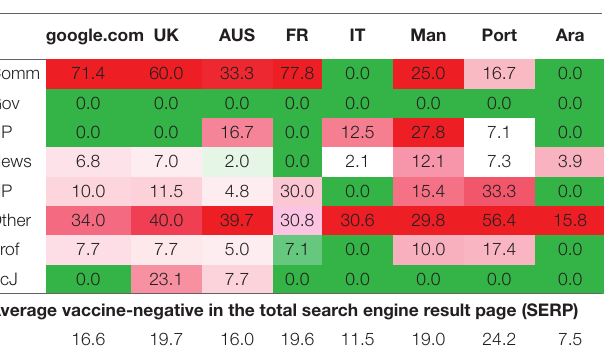
Data indicate the percentage of vaccine-negative webpages in each typology. Cells are color coded to show difference from “expected” based on the frequency in the total SERP shown in the bottom row (red, above the expected frequency; green, below the expected